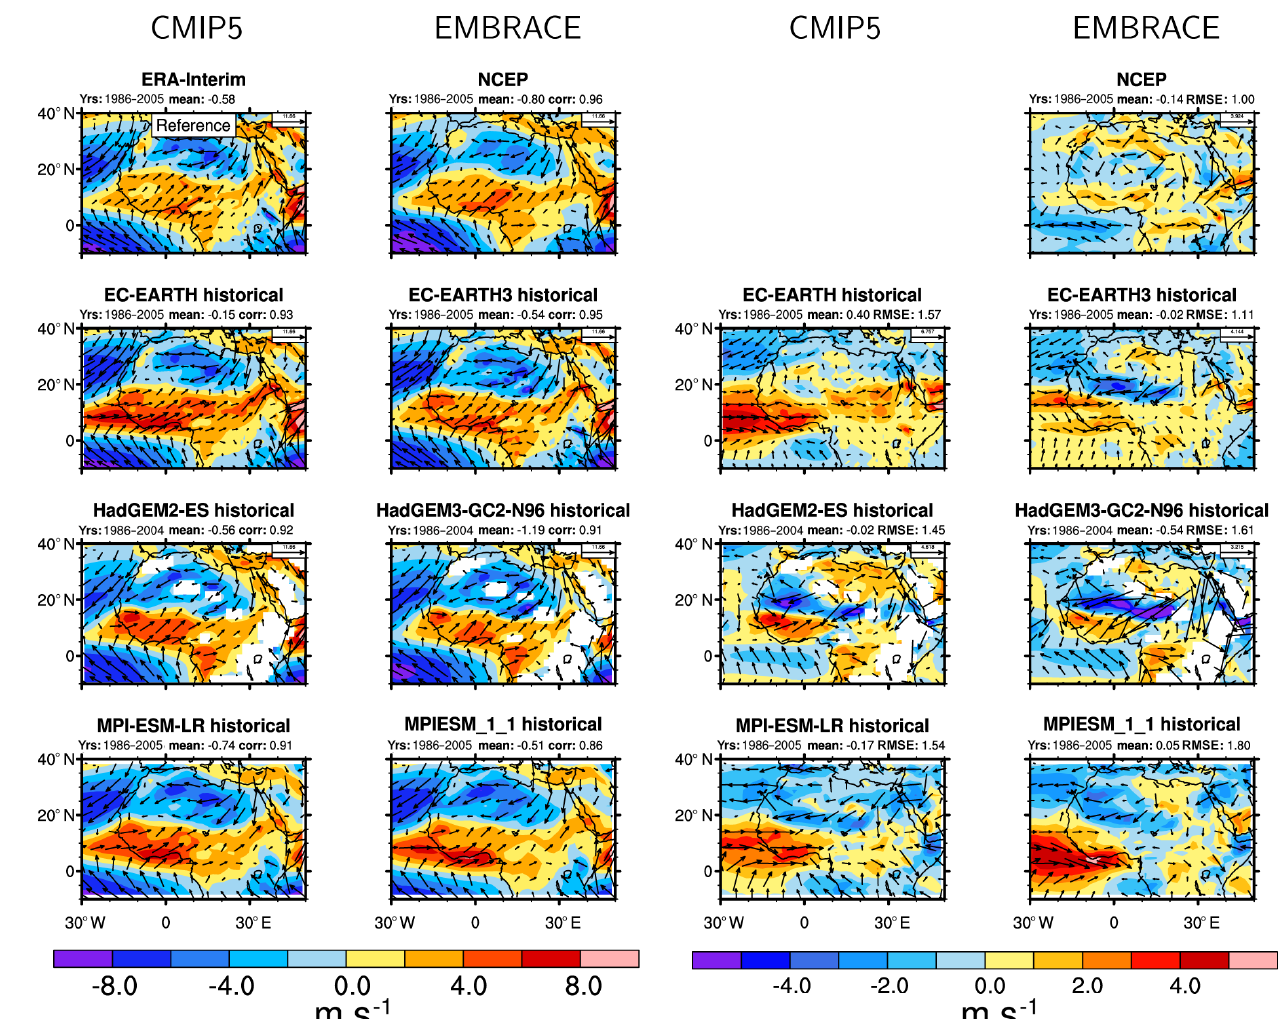
Figure 9. Leftmost two columns: seasonal mean wind speed at 925hPa for JJAS from reanalysis data (ERA-Interim and NCEP 1) and the coupled simulations averaged over the years 1986–2005 (HadGEM: 1986–2004). Rightmost two columns: differences relative to ERA- Interim. Columns 1 and 3 show the original CMIP5 model versions, columns 2 and 4 the EMBRACE-updated models. The domain-averaged annual mean (“mean”), linear pattern correlation (“corr”; leftmost two columns), mean bias (“mean”), and root mean square error (RMSE; rightmost two columns) compared with ERA-Interim are given above the individual